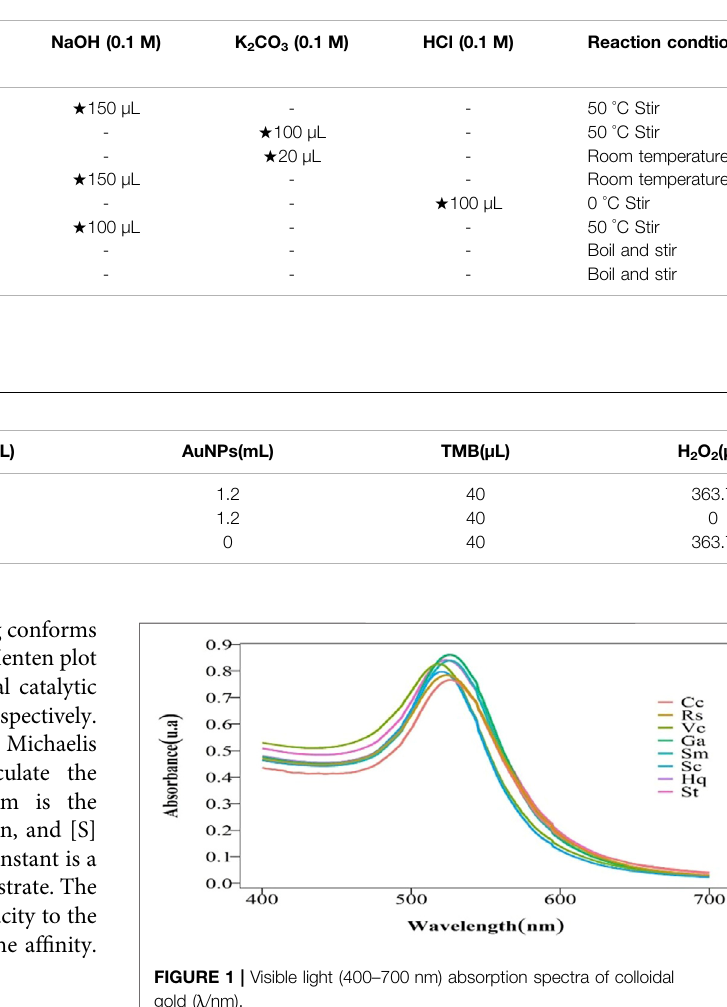
TABLE 1 | Proportion of reagents for preparing colloidal gold. Reducing agent concentration